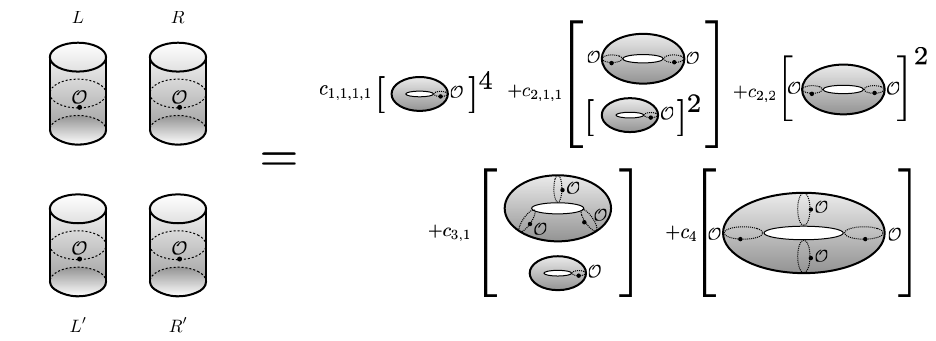
Figure 3 . A schematic picture for higher moments calculation in TPQ states as (4.31). In partic- ular, we can see the generalization of the bra-ket wormholes. (In (4.31), we neglected the forth and fifth terms as these are further suppressed by the power of e − S .) Note that we do not describe the detail of each operator. Also, we represent all operators in terms of a single